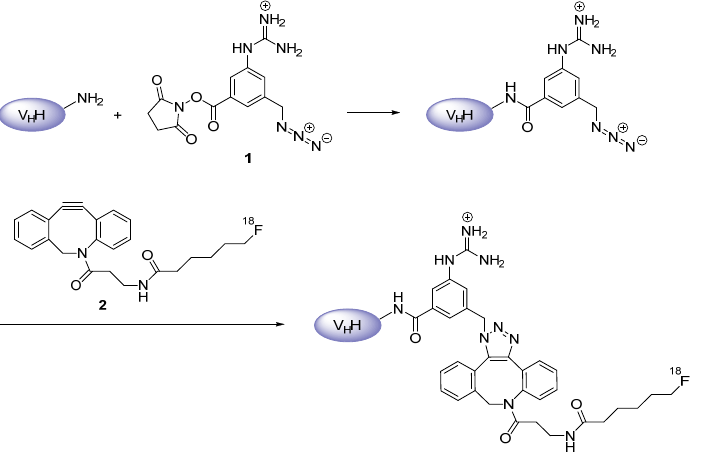
Figure 5. Pre-derivatization on primary amines of the nanobody with 1 , followed by 18 F-introduction via 2 in a strain-promoted azide-alkyne cycloaddition reaction [36]. A certain limitation of these indirect methods for radiofluorinating the anti-HER2 nanobodies was the high kidney uptake of the radiotracers. Therefore, another 18 F-labeled prosthetic agent, namely 2,3,5,6-tetrafluorophenyl 6-[ 18 F]-fluoronicotinate ([ 18 F]TFPFN) (Figure 4), has been applied in order to radiolabel 2Rs15d and 5F7, respectively [37]. Its structure is based on a pyridine ring bearing the radiofluorine in position 6 and the carboxylic acid functionality in position 3, which in turn is activated as a 2,3,5,6-tetrafluorophenyl ester, enabling the random conjugation to primary amines within the nanobodies’ amino acid sequence. This molecule is closely related to the most commonly used prosthetic group for 18 F-labeling, N -succinimidyl-4-[ 18 F]-fluorobenzoate ([ 18 F]SFB) (Figure 4), differing from it only by the aromatic system, which herein is a benzene ring, and by the activated ester, i.e., a succinimide ester. Consequently, the attachment to both anti-HER2 nanobodies was conducted analogously [3,30]. Indeed, the introduction of these two very similar prosthetic groups to 5F7 and 2Rs15d has proven valuable in terms of a lower renal uptake of the resulting radiotracers. Apart from HER2, [ 18 F]SFB has been additionally used to radiofluorinate the two mouse-human cross-reactive nanobodies MMR 3.49 and cAbVCAM-1 − 5, specifically targeting the macrophage mannose receptor (MMR) and the vascular cell adhesion molecule (VCAM)-1, respectively [38,39]. Rashidian et al. described a very elegant method for radiofluorinating nanobodies (VHHDC13, VHH7, VHHDC8), which were specifically directed against the mouse cell surface marker CD11b or the mouse class II major histocompatibility complex (MHC) [40–42]. The two anti-class II nanobodies, VHH7 and VHHDC8, recognize a closely related epitope, but differ from each other in their affinity towards the target, which is 3–4 fold higher for VHHDC8 than for VHH7 [40]. These two as well as the anti-CD11b nanobody VHHDC13 were engi- neered in a way that they bore a sortase A-recognition motif (sortag), enabling C -terminal site-specific conjugation. The sortag itself embodies the oligopeptide Leu-Pro-Xxx-Thr-Gly (LPXTG), in which Xxx is any amino acid besides cysteine, and glycine is not the final C -terminal amino acid of the whole protein chain [43–45]. Sortase A is an enzyme found in Staphylococcus aureus that catalyzes transpeptidation reactions. Upon recognition, the thiol (-SH) of the transpeptidase’s active-site cysteine nucleophilically attacks the carbonyl carbon (C=O) of the sortag’s threonine, forming an acyl-enzyme intermediate (Figure 6). Subsequently, the carbonyl carbon of the thioester is nucleophilically attacked by the amino group of a different oligoglycine which is present in molar excess, preventing the reverse re- action.